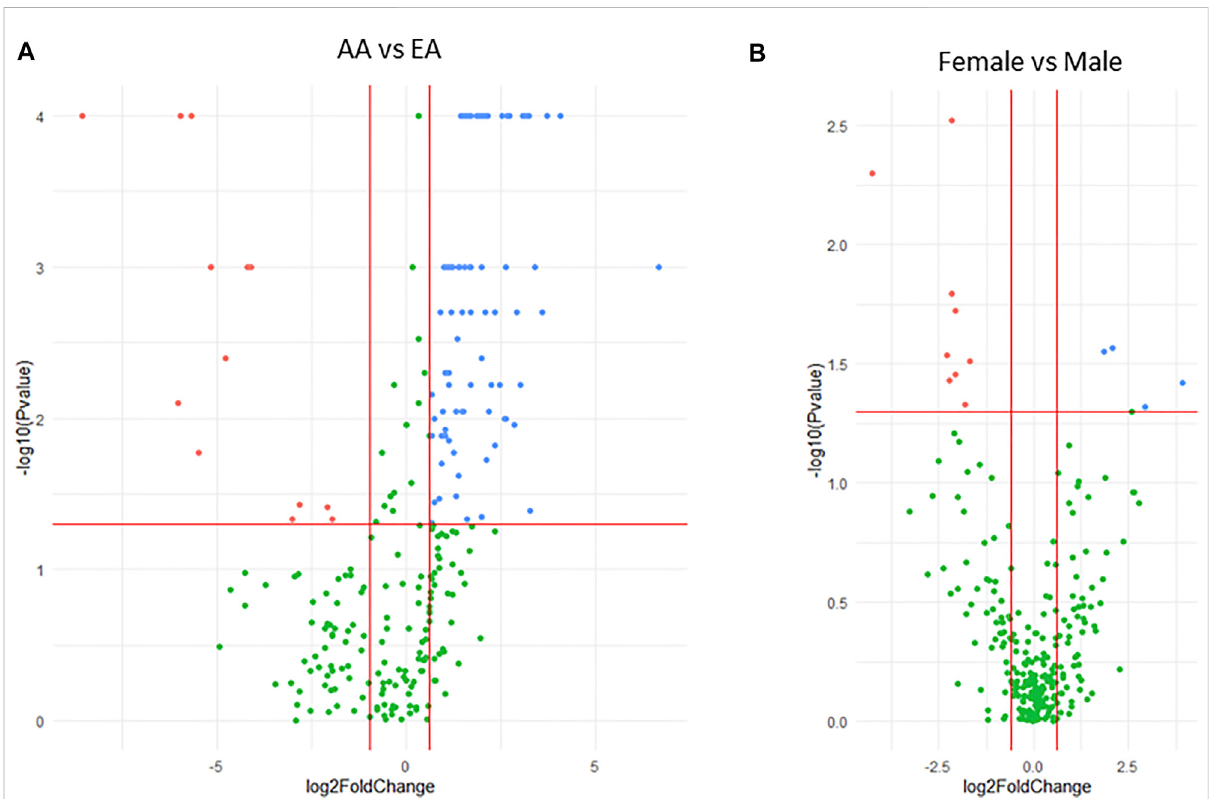
FIGURE 1 Volcano plots showing differential expression of miRNAs between race (A) and sex (B) in liver samples. The plots indicate expression of signi fi cantly higher (blue dots) and lower (red dots) miRNAs in (A) AA vs. EA or (B) female vs. male. Negative log10 p -values are plotted on the y-axis, and log2 normalized fold change in expression is on the x-axis. For a miRNA to be considered as both signi fi cantly and differentially expressed a 2- fold difference and p ≤ 0.05 was